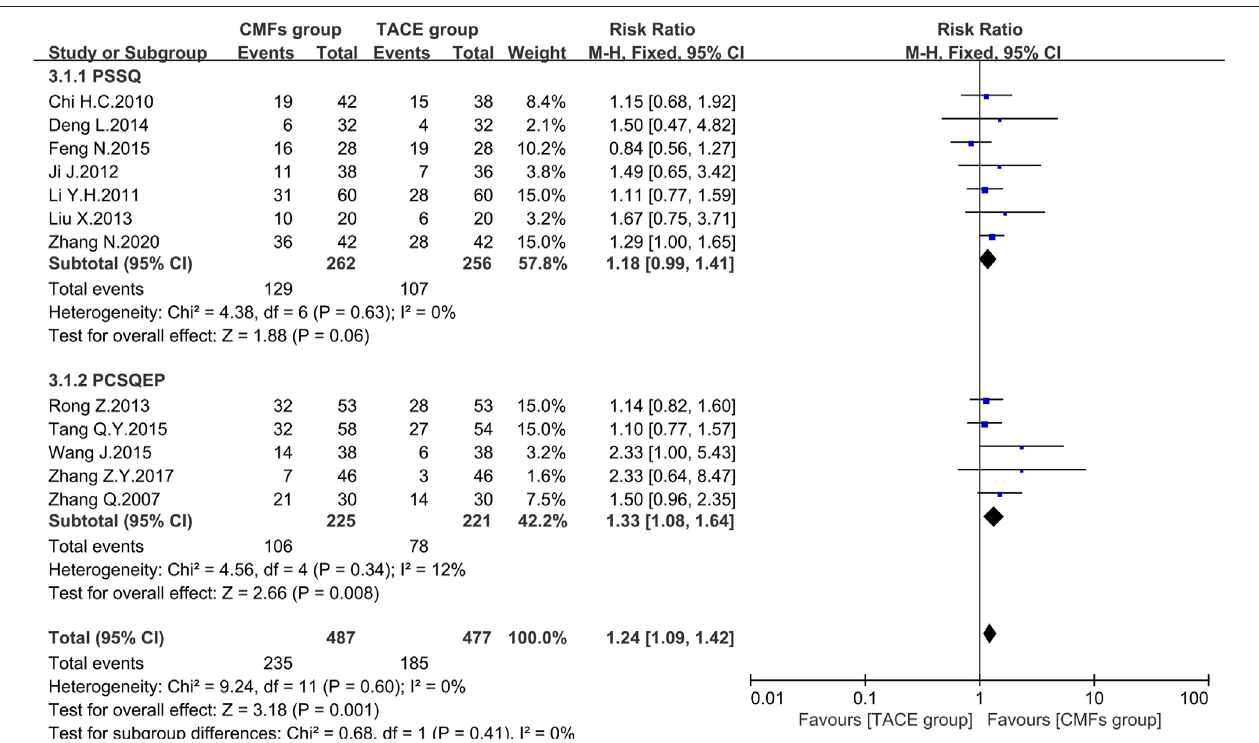
FIGURE 6 | Effect of CMFs group versus TACE group on ORR applied the WHO criteria, including a comparison between PSSQ and PCSQEP in the subgroup.